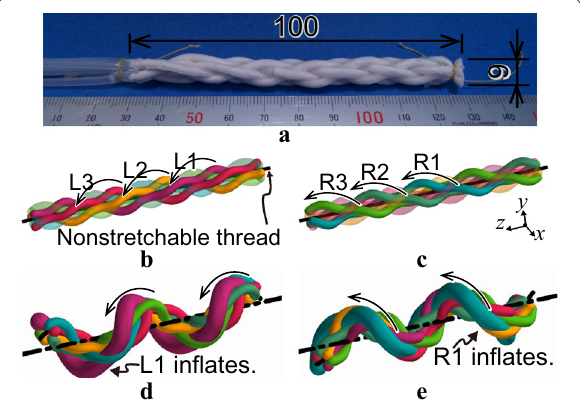
Fig. 1 Six braided-tube in-pipe locomotive device. Group R tubes form the right-handed helices, and Group L tubes form the left-handed helices. a is an appearance of a device. b , c are Group L and R tubes, respectively. d , e Deformations with an inflation with a left- and right-handed tubes. A left- and right-handed tubes deforms a device into right- and left-handed helices,